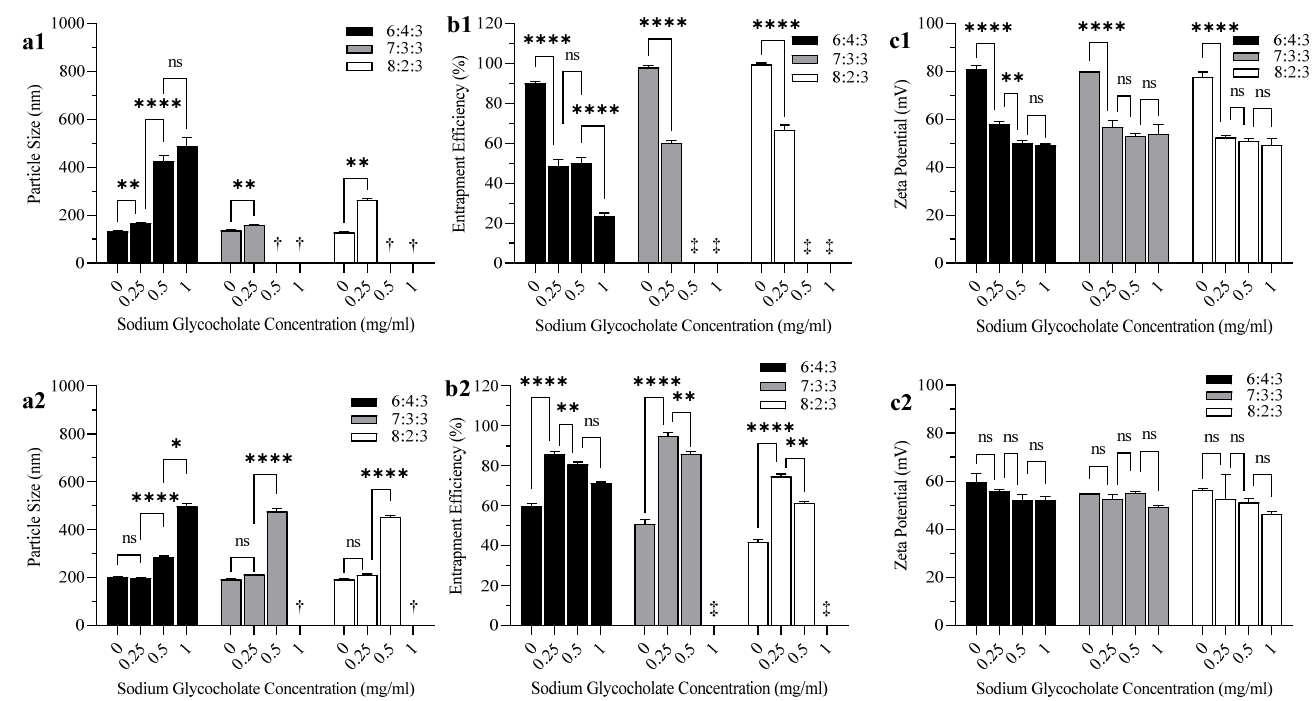
Figure 3. The effect of SGC (bile salt) concentration (mg/mL) on the ( a1 , a2 ) particle size, ( b1 , b2 ) EE, and ( c1 , c2 ) zeta potential of liposomes with DPPC:CH:SA molar ratios of 6:4:3, 7:3:3, and 8:2:3 prepared by sonication ( a1 – c1 ) and extrusion ( a2 – c2 ). Notes: The data represents the mean ± standard deviation (n = 3). (ns p ≥ 0.05, * p < 0.05, ** p < 0.01, **** p < 0.0001) compared to adjacent formulation(s). †: Results do not meet DLS criteria (not included in two-way ANOVA). ‡: Precipitated drug cannot be separated from liposomes due to the large particle size of the liposomal vesicles (>1000 nm).